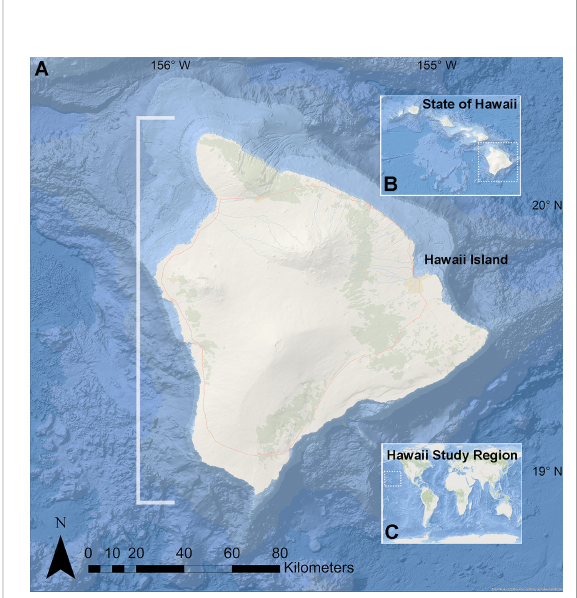
FIGURE 1 Map of study region on Hawai ’ i island, Hawai ’ i USA. (A) Hawai ’ i Island. (B) Location of Hawai ’ i Island, the southernmost of the Hawaiian Islands. (C) Location of the Hawaiian Archipelago in the north Paci fi c Ocean. White bracket indicates the west Hawai ’ i region in which survey data and specimens were